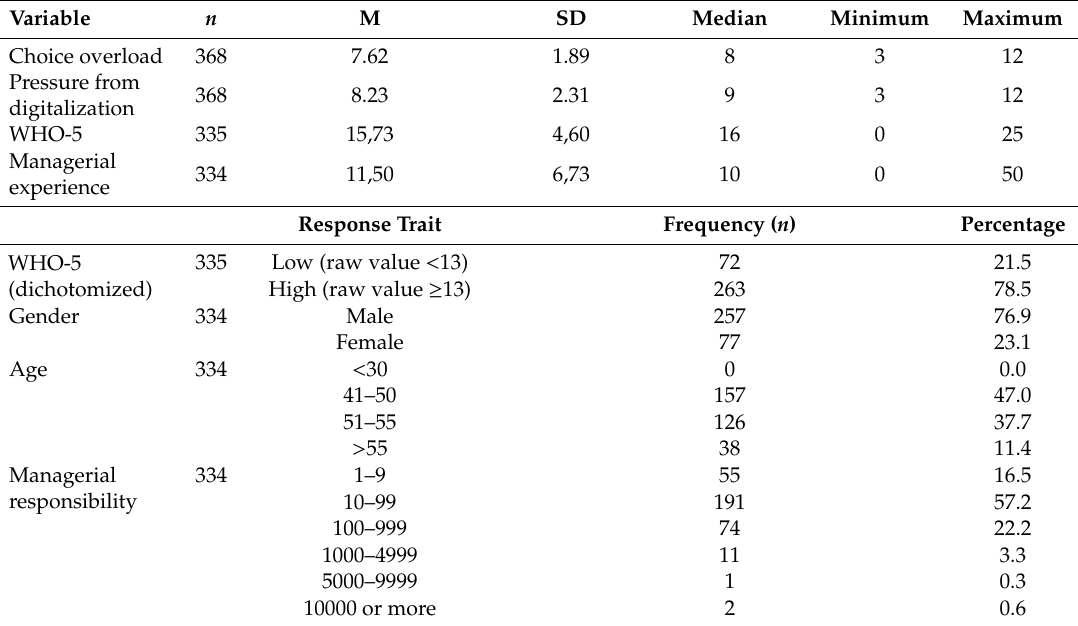
Figure 1. Flowchart of the selection of the managers’ sample. Table 1. Descriptive characteristics for all model